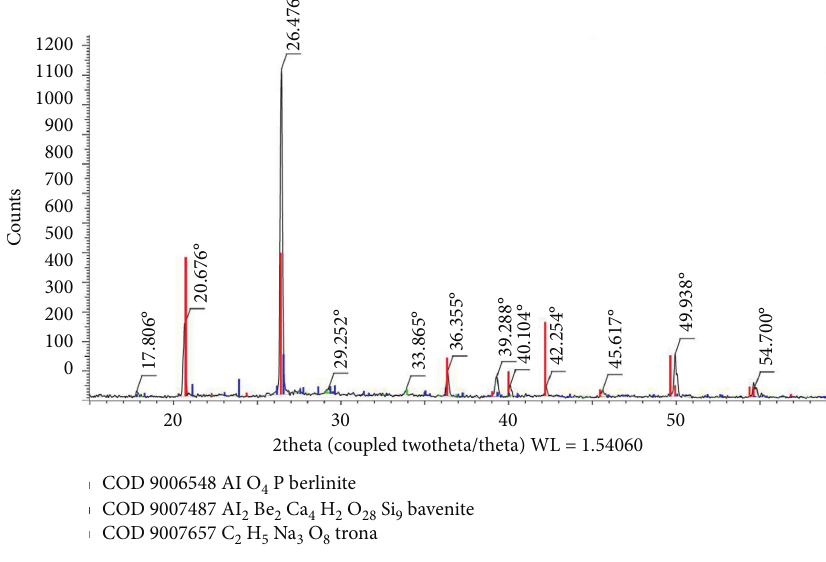
Figure 11: XRD diffractogram for PPC (AT).